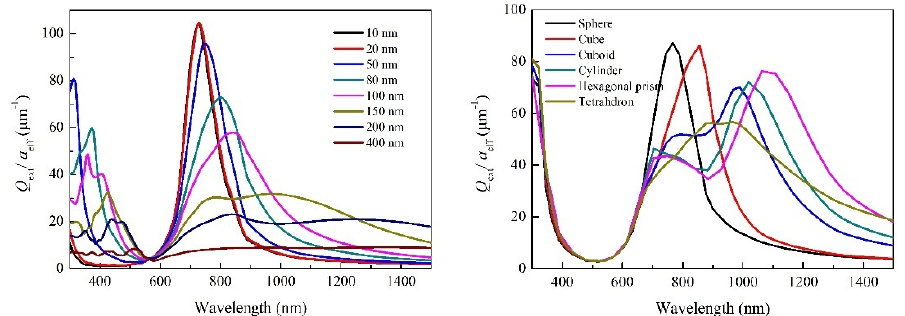
Figure 8. Extinction curves of spherical-shaped Na 0.522 WO 3 particles with different sizes (left) and differently shaped Na 0.522 WO 3 particles with size of 50 nm (right).